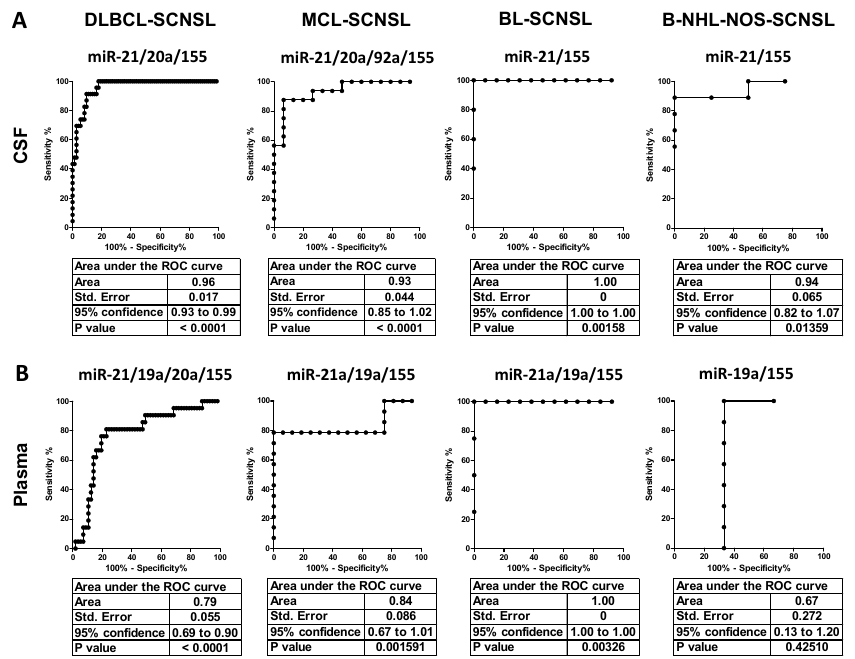
Figure 2. Receiver Operating Characteristics (ROC) of oncomiR indices for discrimination of CNS- involving and systemic lymphomas. ( A ) CSF and ( B ) plasma of indicated CNS lymphoma subtypes. The X -axes indicate % of specificity and the Y -axes indicate 100—% of sensitivity. The OncomiR index (logistic regression model) combines the expression of individual oncomiRs into a single classifier, yielding higher specificity/sensitivity.